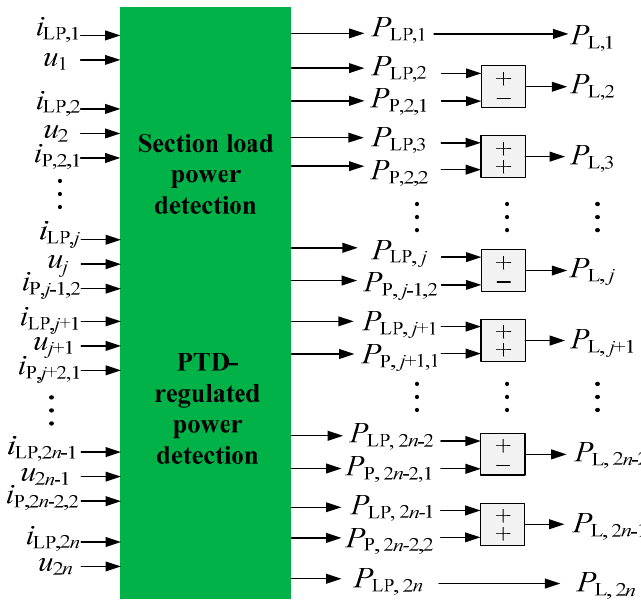
Figure 14. Detection block diagram of locomotive load power in centralized control.